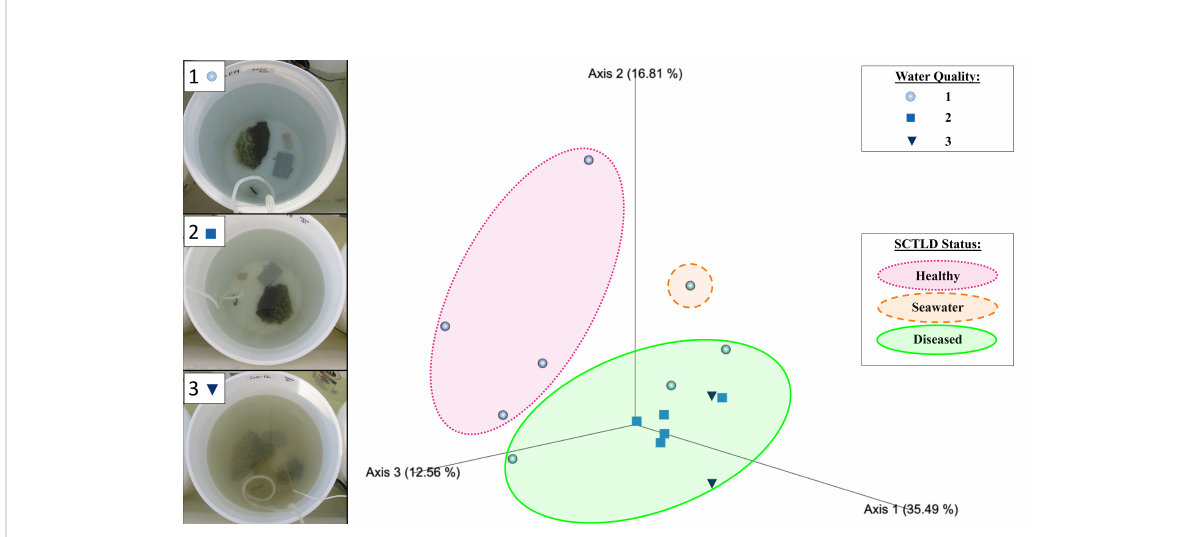
FIGURE 2 Emperor principal coordinates analysis plot based on a weighted UniFrac distance matrix, depicting the relationships between the bio fi lm prokaryotic microbial communities resulting from different mesocosms, with mesocosm water quality and donor coral health status indicated. Water quality values assigned included 1 ● (clear), 2 ■ (mild turbidity and color change), and 3 ▼ (cloudy, visible color change), as exempli fi ed in the photos on the left. Overlays indicate bio fi lm samples sourced from healthy donor coral mesocosms (in pink), the fi ltered seawater (FSW) mesocosm (in orange), and diseased donor coral mesocosms (in green). Axis percentage values indicate the percent variation explained by that